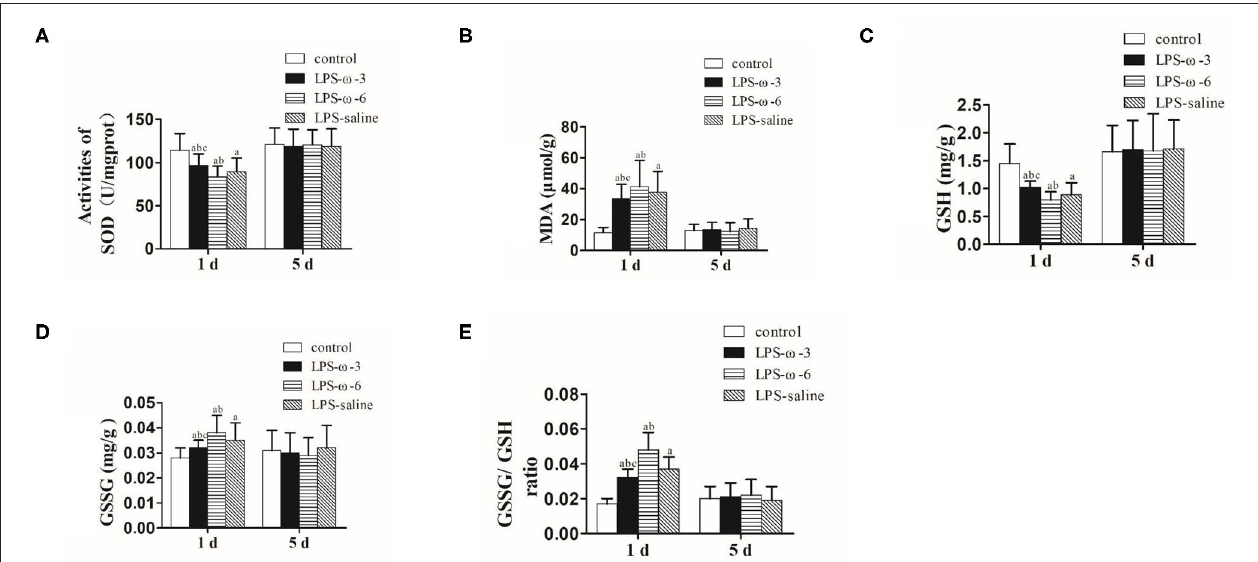
FIGURE 3 | The amounts of SOD (A) , MDA (B) , GSH (C) , GSSG (D) , and GSSG/GSH (E) in the hippocampal tissues from the different groups. The data points represent the mean ± SD; n = 12 ( a P < 0.05 compared with the control group; b P < 0.05 compared with the LPS group; c P < 0.05 compared with the ω -6 group). SOD, superoxide dismutase; MDA, malondialdehyde; GSH, glutathione; GSSG, oxidized